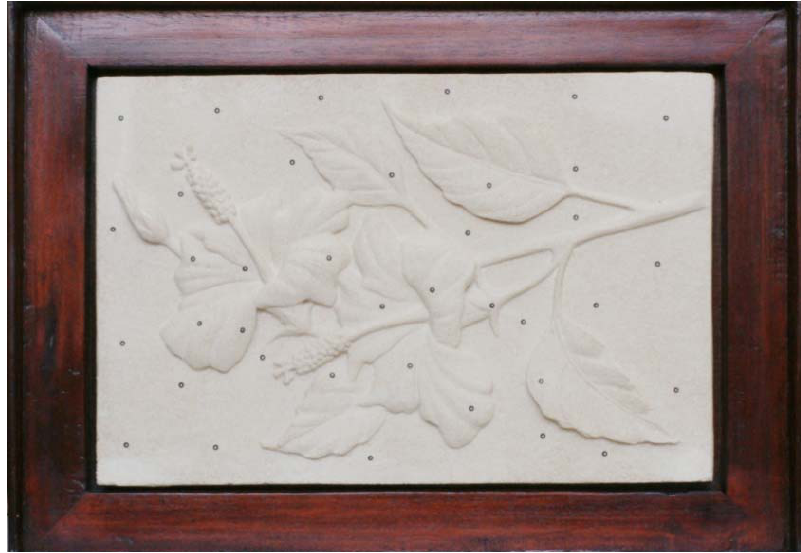
Figure 12. Sample image for 3D modeling (Stone